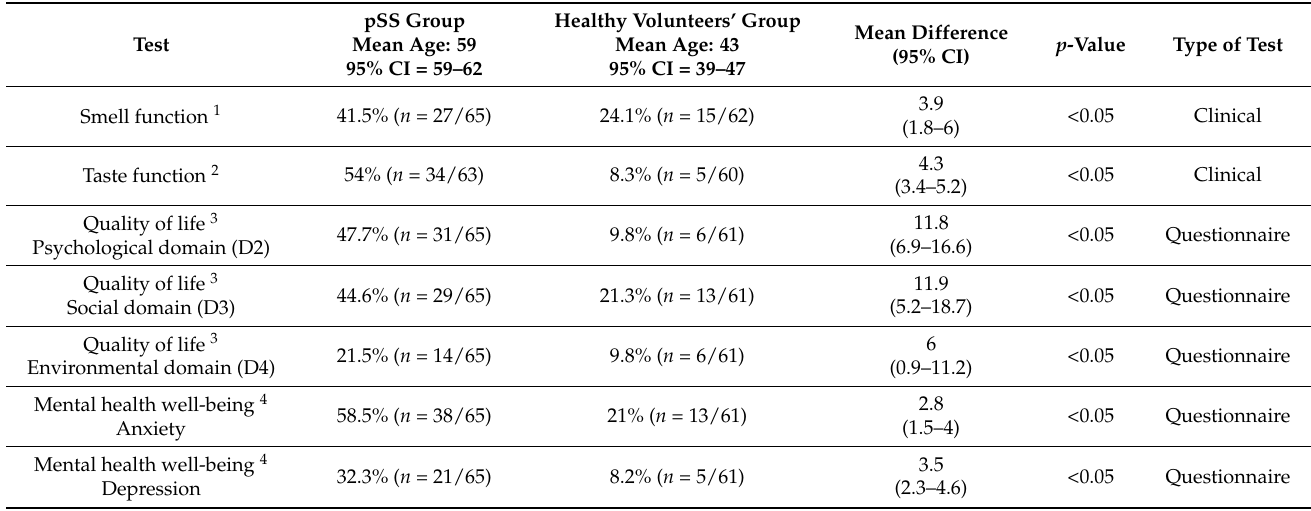
Table 2. Comparison of the dysfunction rate of the study outcomes in pSS patients compared with healthy volunteers.